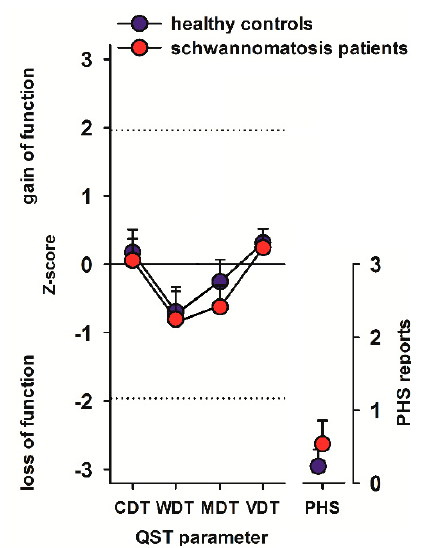
Figure 1. QST profile. CDT: cold detection threshold, WDT: warm detection threshold, MDT: mechanical detection threshold, VDT: vibration detection threshold, PHS: paradoxical heat sensations. Z-scores between − 1.96 and + 1.96 represent the normal range of healthy subjects. All values are normalized for age, gender and testing site on a Z-scale. Z-scores > 1.96 indicate a gain of sensory function; i.e., the subject detects the stimulus at a lesser stimulus intensity than healthy controls in case of detection thresholds (hyperaesthesia). By contrast, Z-scores < − 1.96 indicate a loss of sensory function; i.e., the subject detects the stimulus at a greater stimulus intensity than healthy controls in case of detection thresholds (hypoaesthesia).